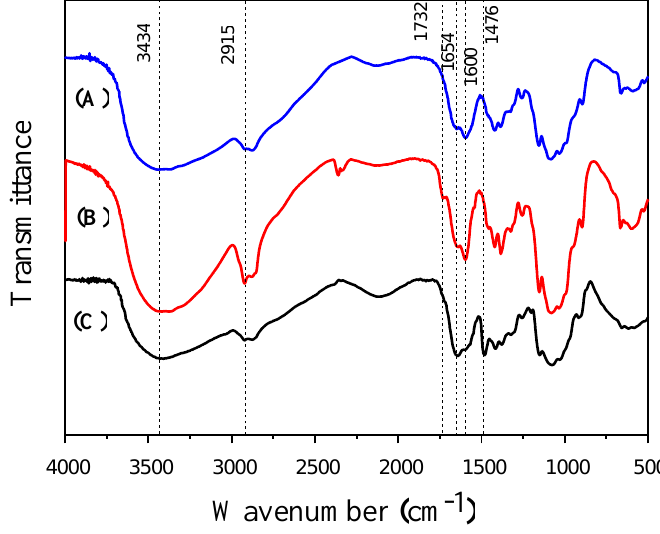
Figure 1. ( A ) Infrared spectra of chitosan, ( B ) DMCh, and ( C ) DMCat.